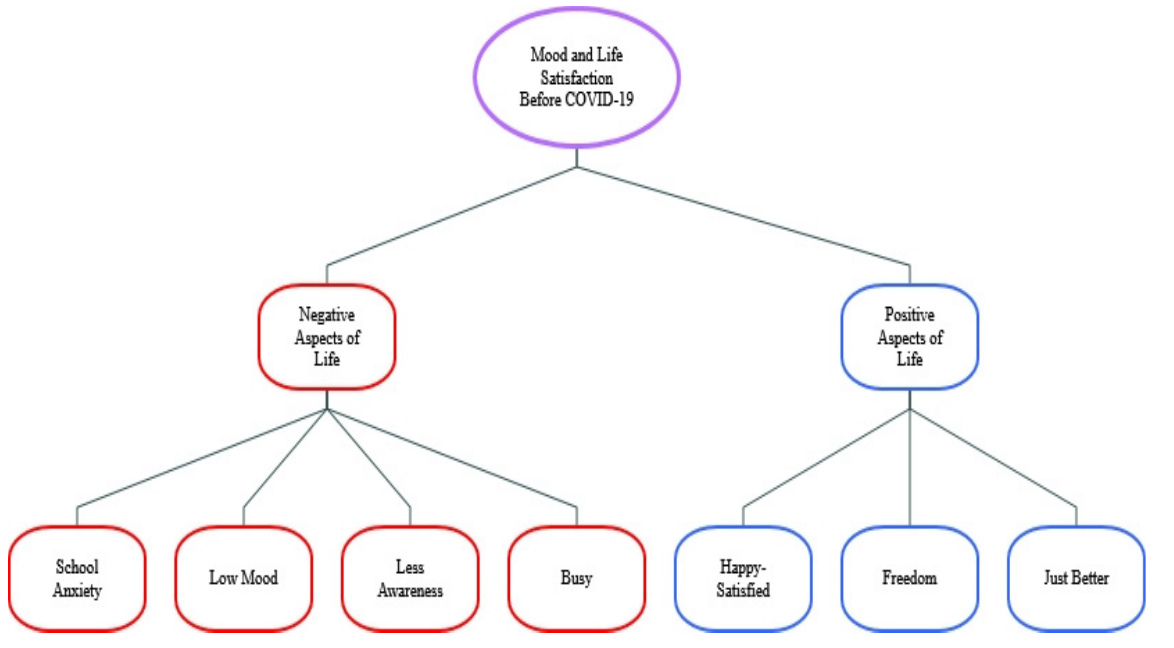
Figure 5. Themes/Sub–themes for mood and life satisfaction before COVID-19.